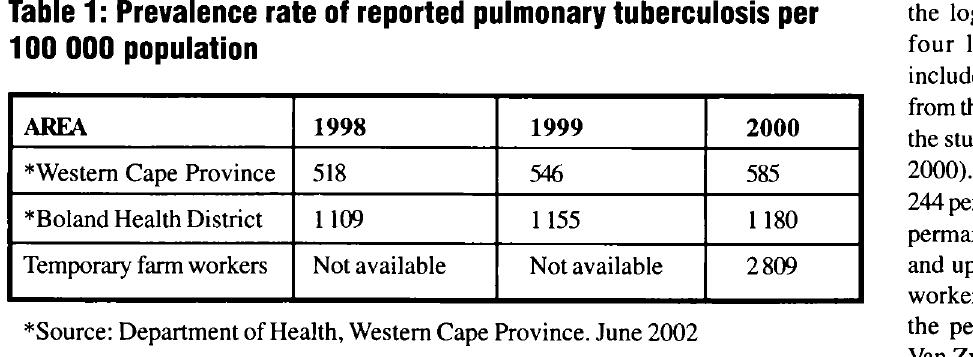
Table 1 : Prevalence rate of reported pulmonary tuberculosis